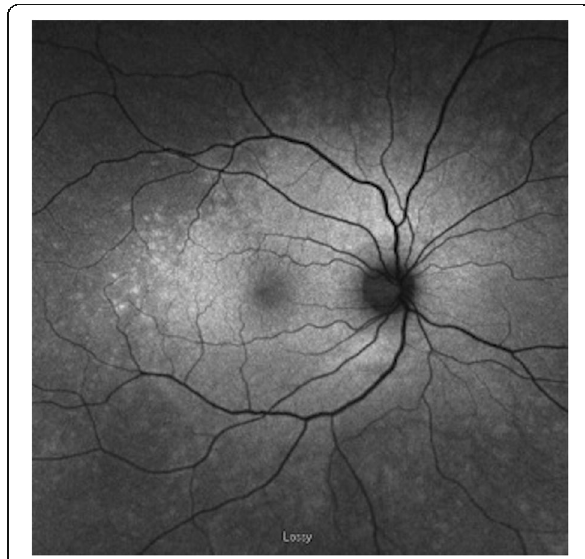
Fig. 3 Fundus autofluorescence in patient with npAIR (patient 13). FAF demonstrates high-level detail of speckled hyperautofluorescence